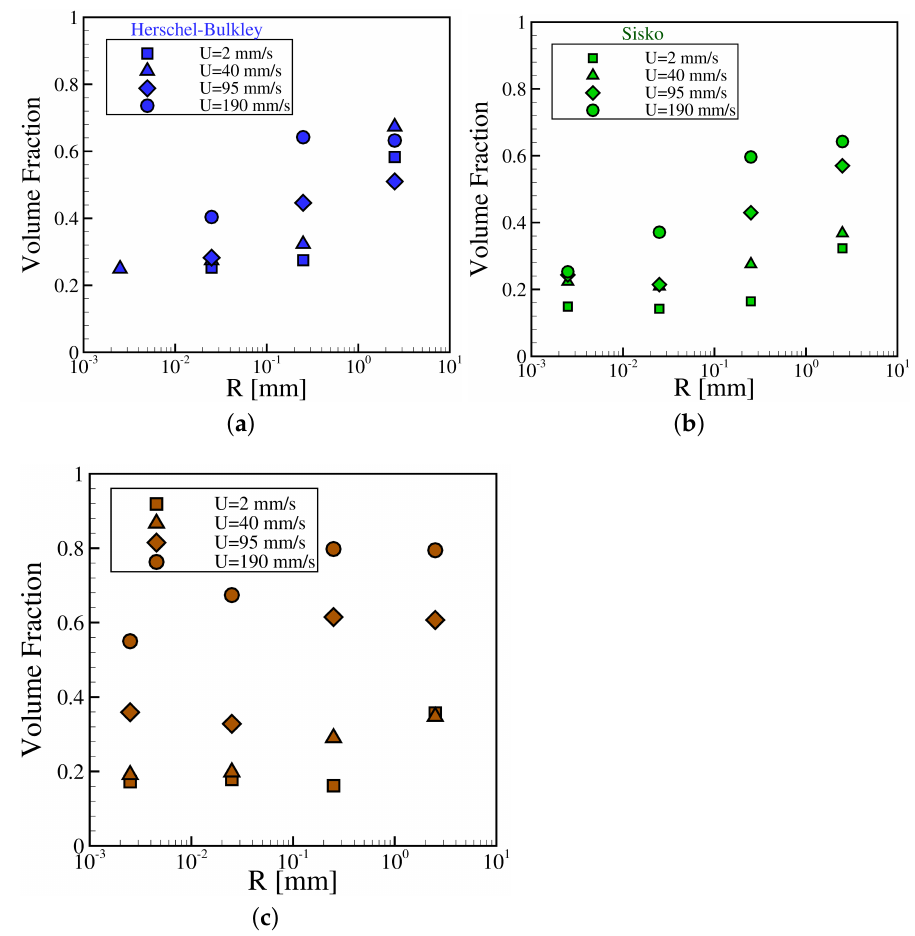
Figure 10. The volume fraction of different inks, i.e., ( a ) HexaS, ( b ) Hexa1, and ( c ) Newtonian, versus the outer radius of the gravure at different imposed